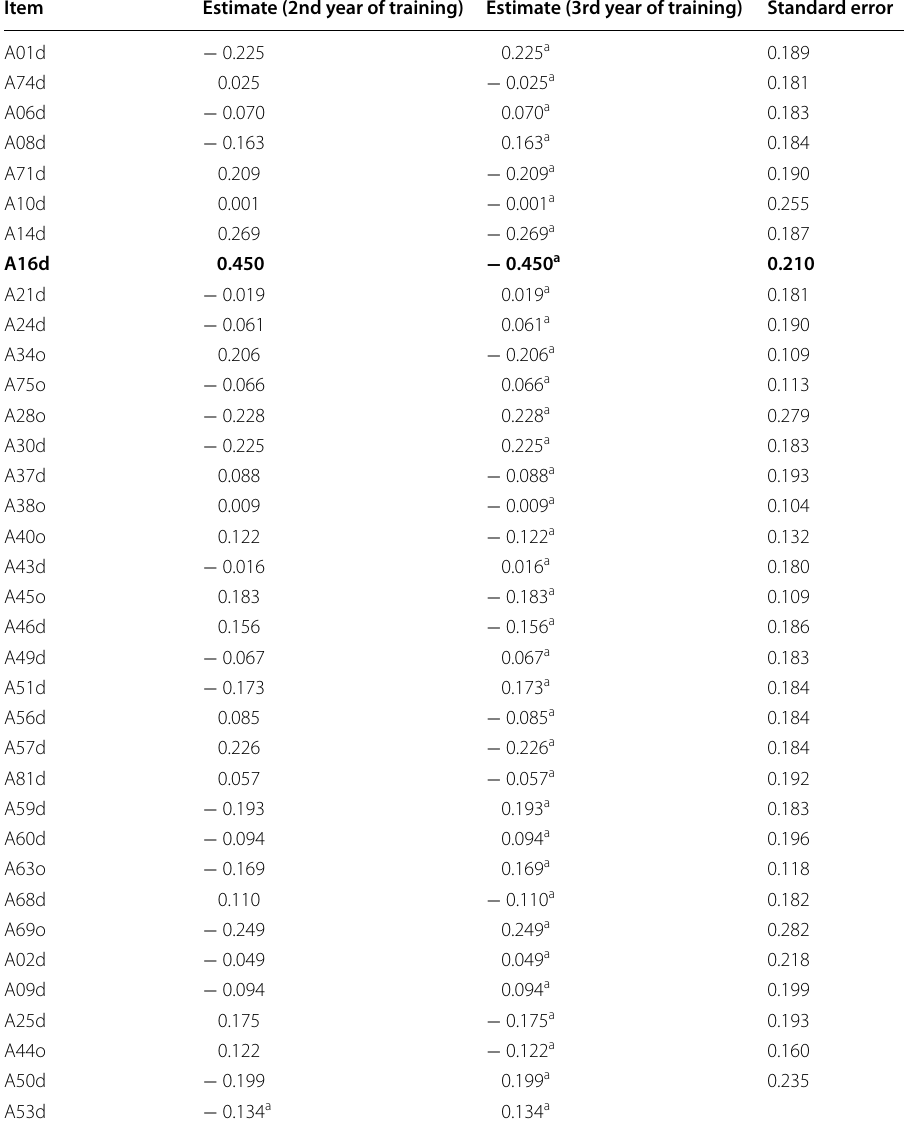
Table 13 DIF item analysis to identify subgroup invariance between years of nursing education at the item level for measurement in the second